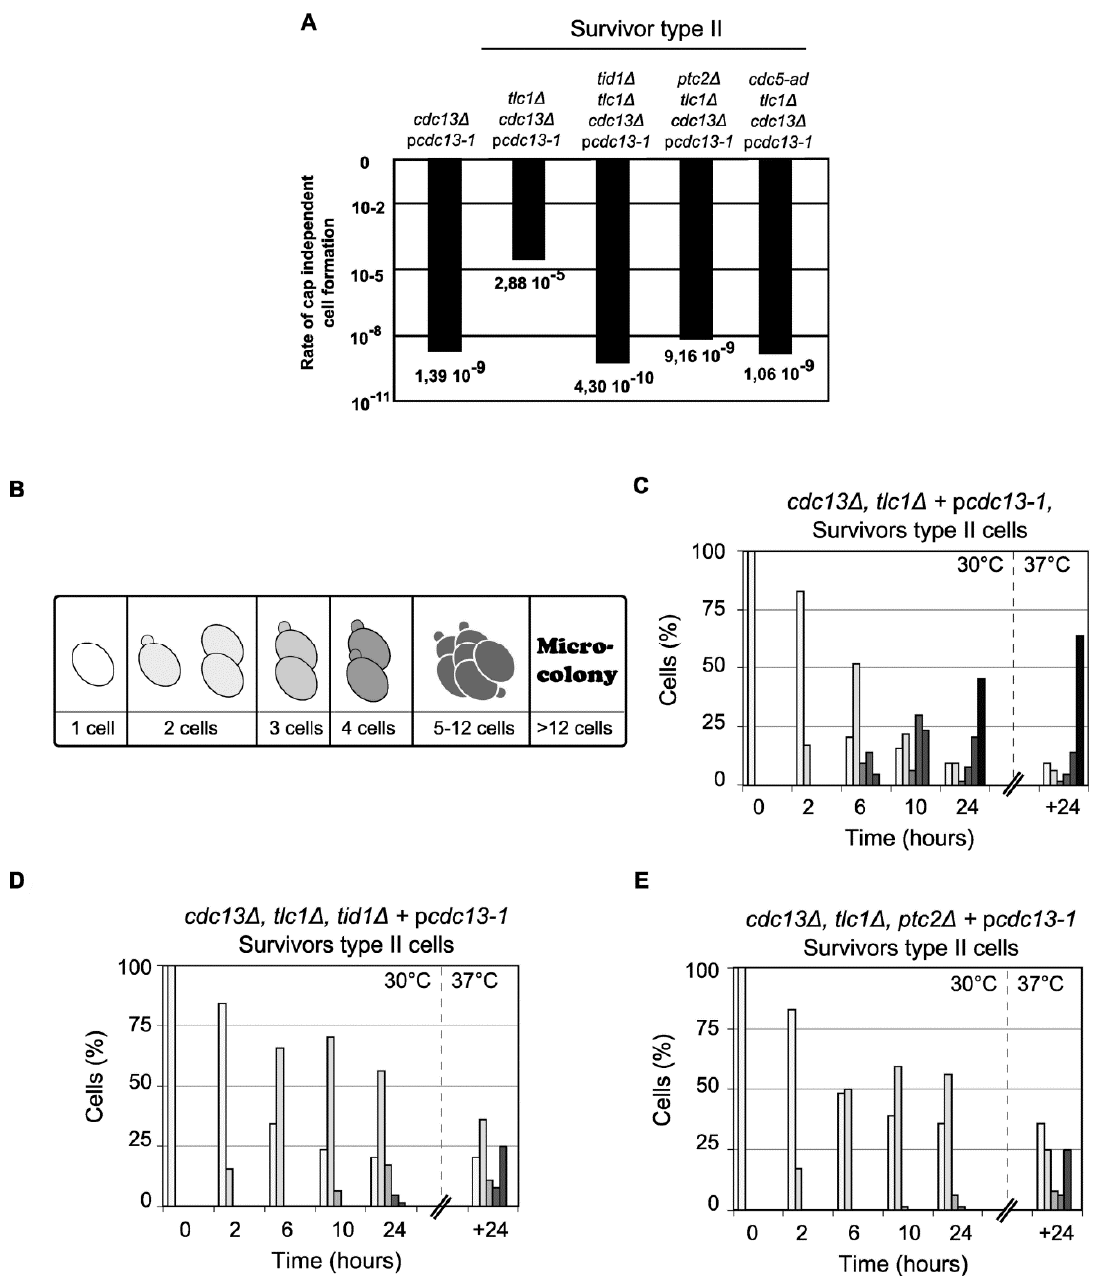
FIGURE 4: The formation of cdc13 -independent survivors ( cdc13 Δ) requires DSB adaptation genes. (A) The rate of successful colony for- mation was calculated by fluctuation test foAr five strains: (i) telomerase positive controls, cdc13 Δ + pcdc13-1 (VKY20), (ii) type II survivors: tlc1 Δ , cdc13 Δ + pcdc13-1 (MLY112), (iii) type II survivors harbouring a deletion of TID1: tid1 Δ , tlc1 Δ , cdc13 Δ + pcdc13-1 (VKY19), (iv) type II survivors harbouring a deletion of PTC2: ptc2 Δ , tlc1 Δ , cdc13 Δ + pcdc13-1 (VKY12), or (v) type II survivors harbouring the cdc5-ad allele: cdc5- ad, tlc1 Δ , cdc13 Δ + pcdc13-1 (MSY421). (B) Schematic representation of standardization for morphological classification used to analyse cell cycle progression of the strains of interest. (C) (D) (E) Single round unbudded cells (64 cells) from three strains described above (ii) (iii) (iv) were identified and arrayed on YEPD plates and incubated at 30°C (restrictive temperature for the cdc13-1 allele). Morphology and growth of cells were inspected microscopically at 2, 6, 10 and 24 h after incubation. Plates were then incubated at 37°C for another 24 h. Colony morphology was recorded as outlined in (B) and results plotted as the percentage of the initial group. (C) Cell cycle progression for the survi- vor type II tlc1 Δ , cdc13 Δ + pcdc13-1 (MLY112); (D) and (E) cell cycle progression for both adaptation deficient mutants tid1 Δ , tlc1 Δ , cdc13 Δ + pcdc13-1 (VKY19), ptc2 Δ , tlc1 Δ , cdc13 Δ + pcdc13-1